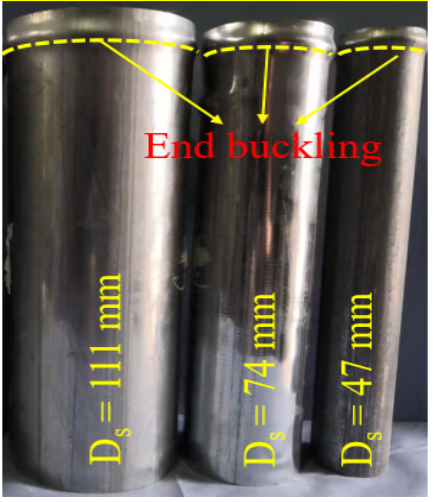
Figure 3. Failure mode of hollow steel tube under axial compression. Table 2. Properties of steel